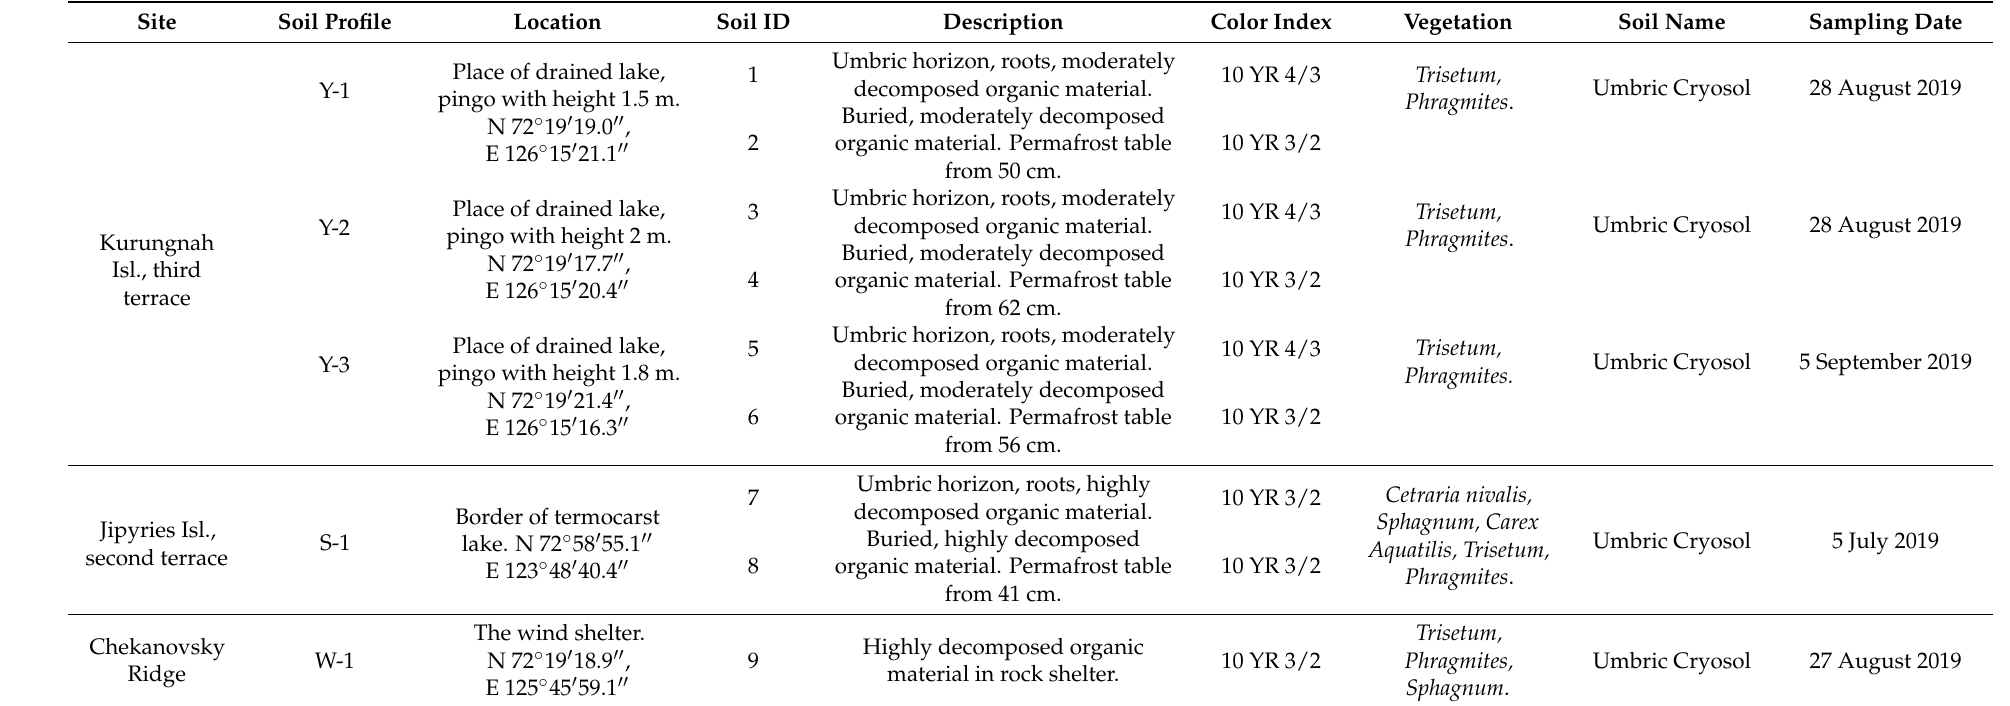
Table 1. Description of study